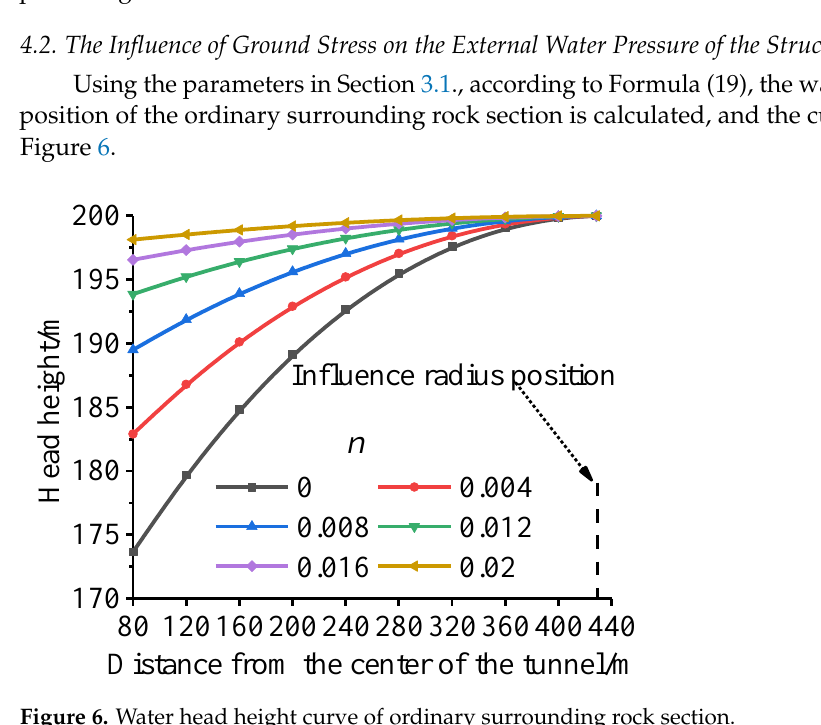
40m 20m Disturbance zone width Figure 5. Head height curve of the inner edge of the supporting structure.